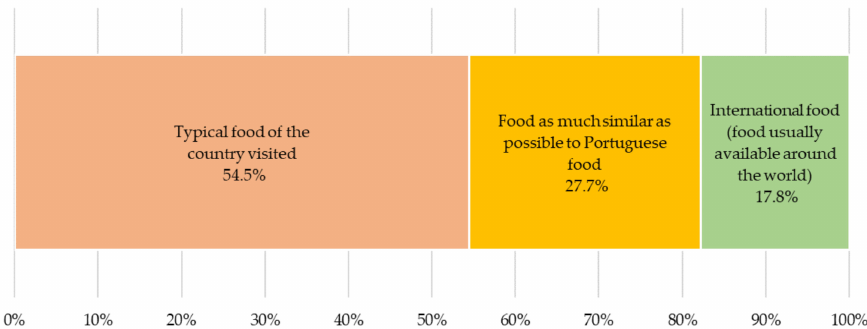
Figure 1. When traveling abroad, what type of food is preferred (legend: rarely = about once/year, occasionally = about 2 to 3 times/year, frequently = plus than 3